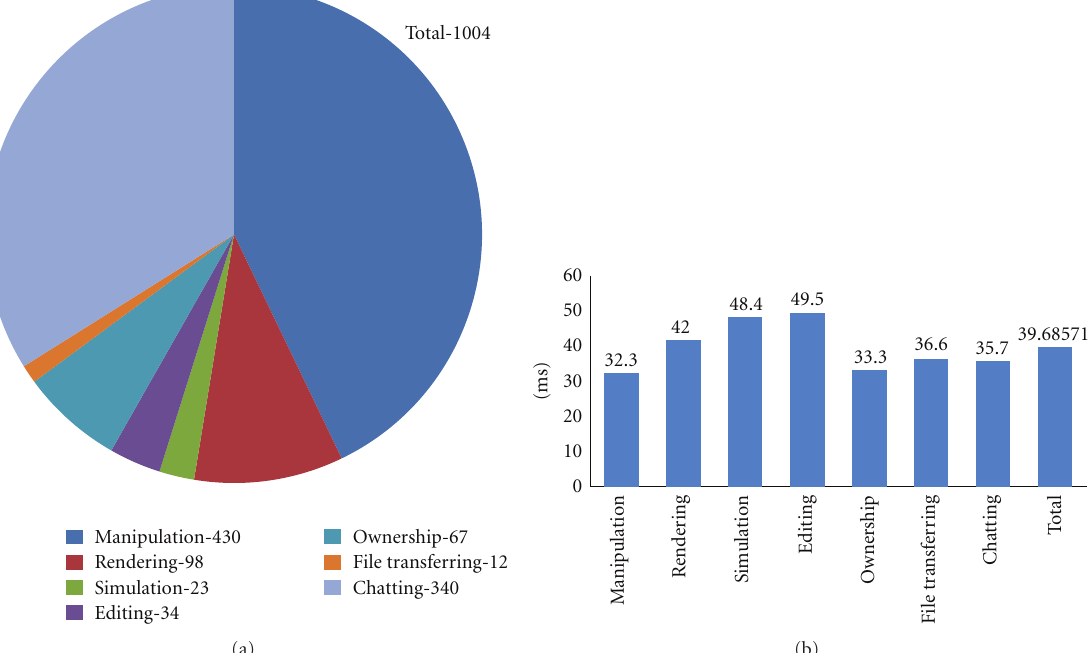
Figure 7: Results of trcollaborative tunneling test: (a) numbers of transformed data according to transformer strategies; (b) average deliver- ing